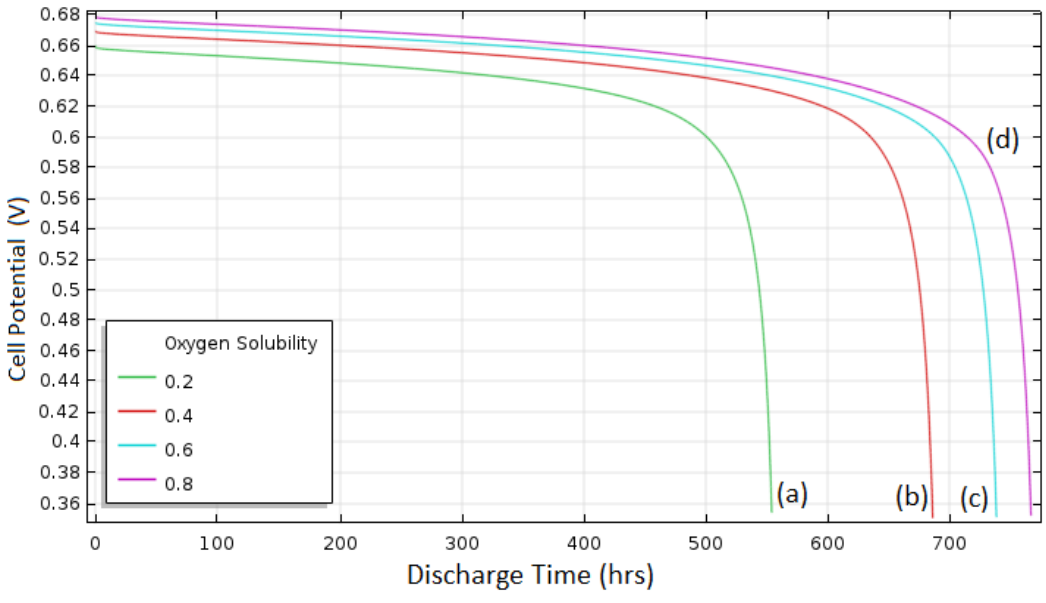
Figure 9. Discharge curves at 1 A / m 2 for O 2 solubilities of (a) 0.2, (b) 0.4, (c) 0.6, and (d) 0.8, with a cathode electrode of which thickness and porosity are 195 µ m and 0.73, respectively.